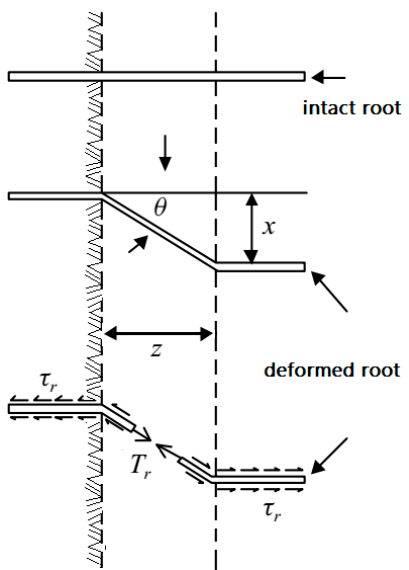
Figure 7. Root reinforcement model with a flexible elastic root aligned horizontally to the shear zone prior to bank failure [33] (adapted from Gray and Leiser (1982) ( z : Thickness of shear zone; x : Deflection of root; τ r : Interface friction between root and soil).